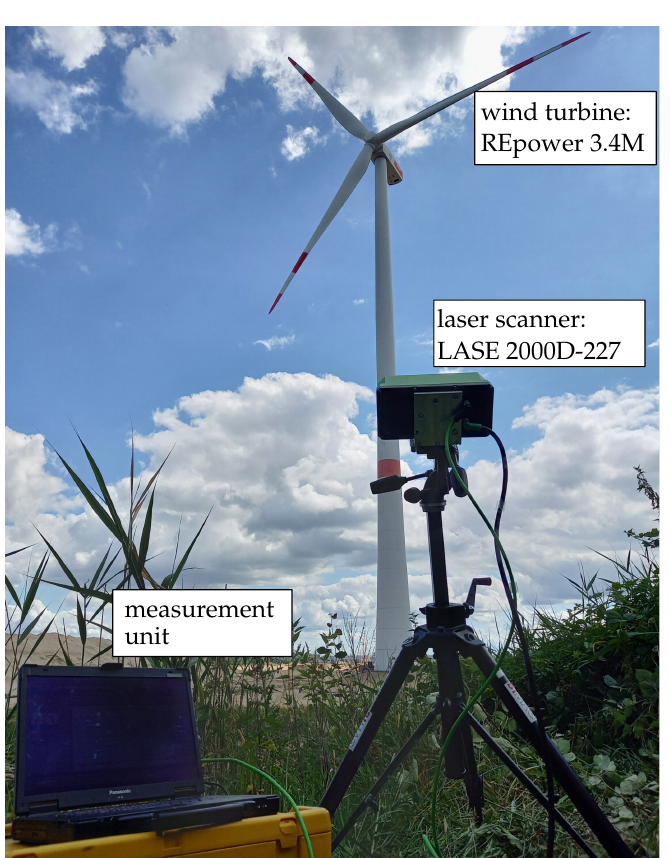
Figure 7. Experimental setup for in-field wind turbine tower deformation measurements including a laser scanner and a measurement